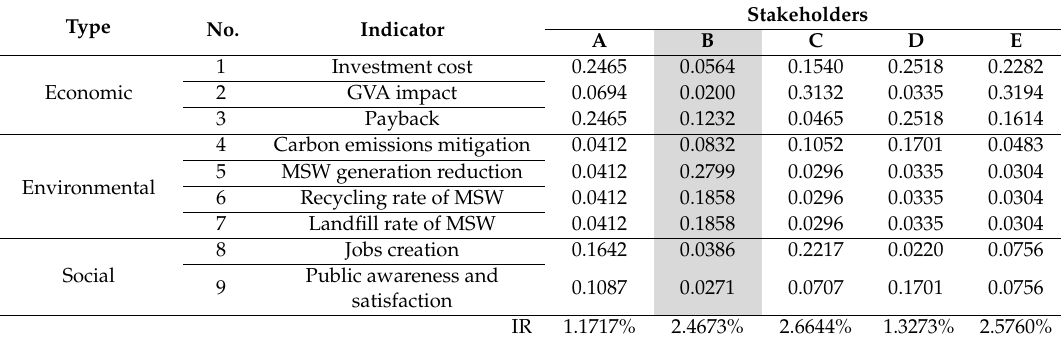
Table 6. Subjective weight vectors for stakeholders.